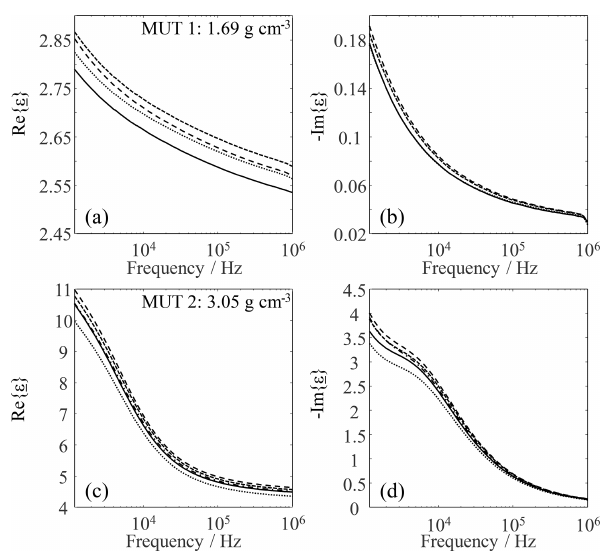
Figure 9. Respective complex permittivity of MUT 1 (a, b) and 2 (c, d) for a given cell filling. Each curve is the average of 20 individual measurements.